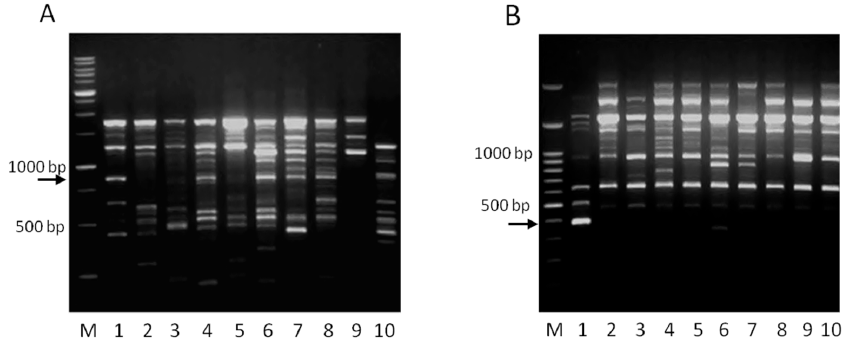
Figure 1. Random Amplified Polymorphic DNA (RAPD) analysis for Lb. pentosus B281 and